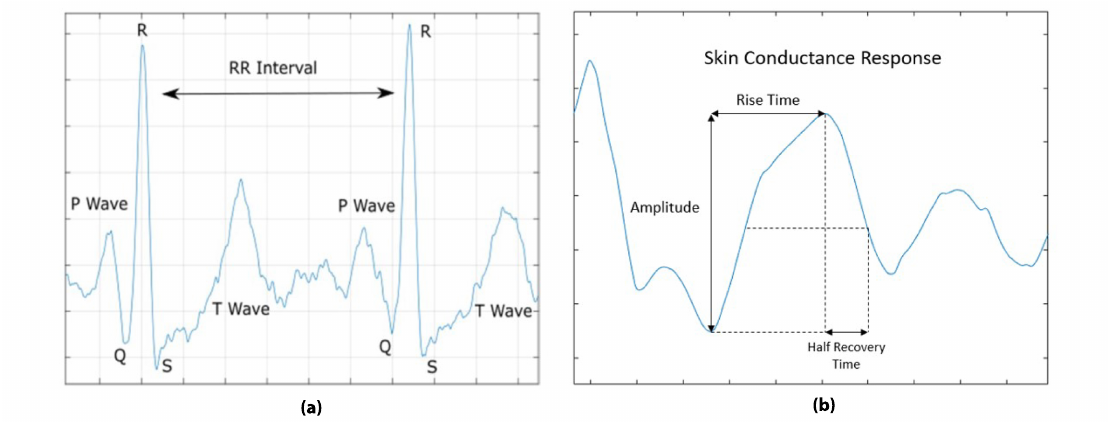
Figure 4. ( a ) Example of the interval between R peaks (RR interval) from ECG signal; ( b ) Example of Skin Conductance Response (SCR) from GSR signal.